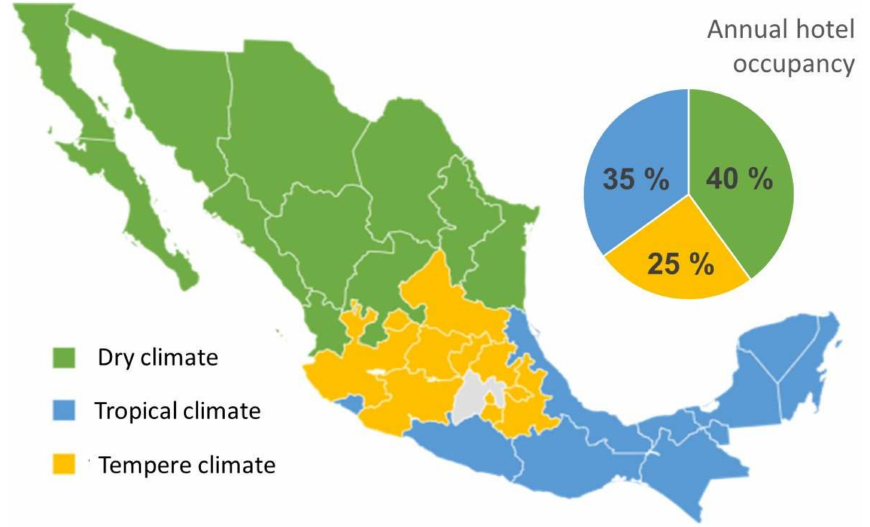
Figure 1. Percentage of hotel occupancy by climatic distribution in the Mexican Republic (Figure developed with data from SECTUR